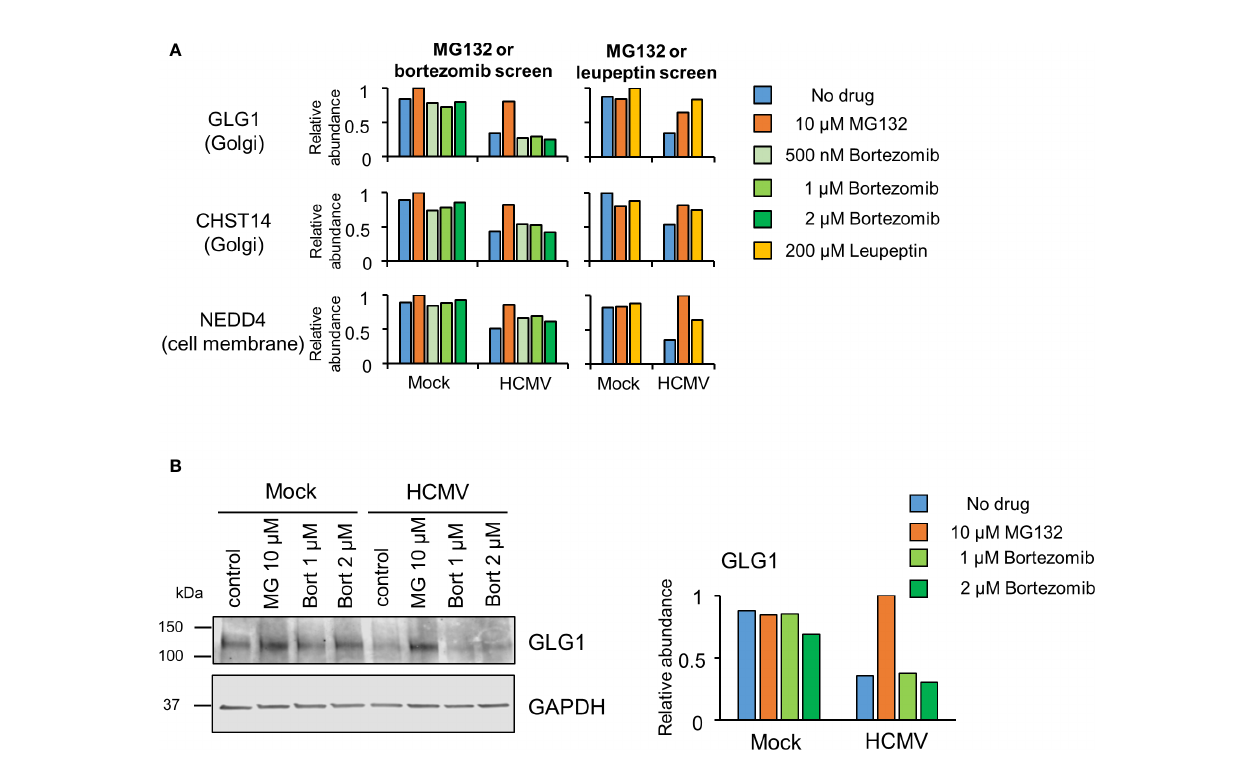
FIGURE 3 | Proteins rescued by MG132 but not bortezomib are also rescued by Leupeptin. (A) Results for GLG1, NEDD4 and CHST14, proteins selectively rescued by MG132 but not bortezomib. The left hand panels show data from the complete MG132/bortezomib screen and the right hand panels show the MG132 (10 µM)/Leupeptin (200 µM) screen (12 hpi) described previously (Nightingale et al., 2018). (B) (Left panel) Immunoblot showing differential effects of proteasome inhibitors MG132 (MG) and bortezomib (bort) on GLG1 protein during HCMV infection (MOI 5, 12 hpi). (Right panel) Quantitation of GLG1 relative to GAPDH (internal loading control).